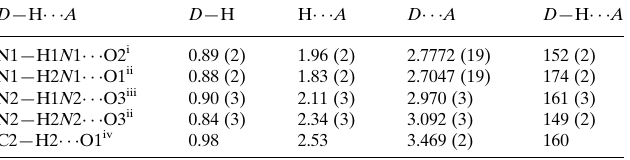
Hydrogen-bond geometry (A˚ , (cid:5)